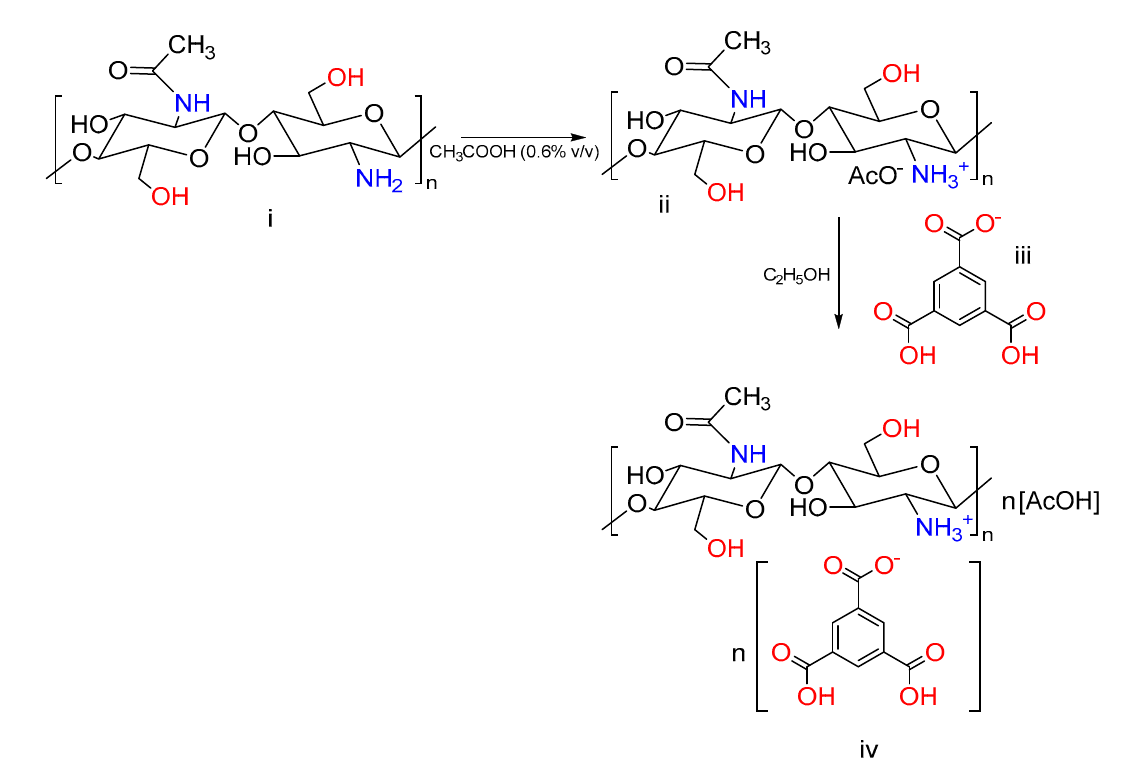
Figure 4. Schematic representation of the cross-linking effect of BTC in the formation of chitosan hydrogels: ( i ) chitosan; ( ii ) protonated chitosan; ( iii ) BTC; and ( iv ) chitosan glucosamine carboxylate salt.